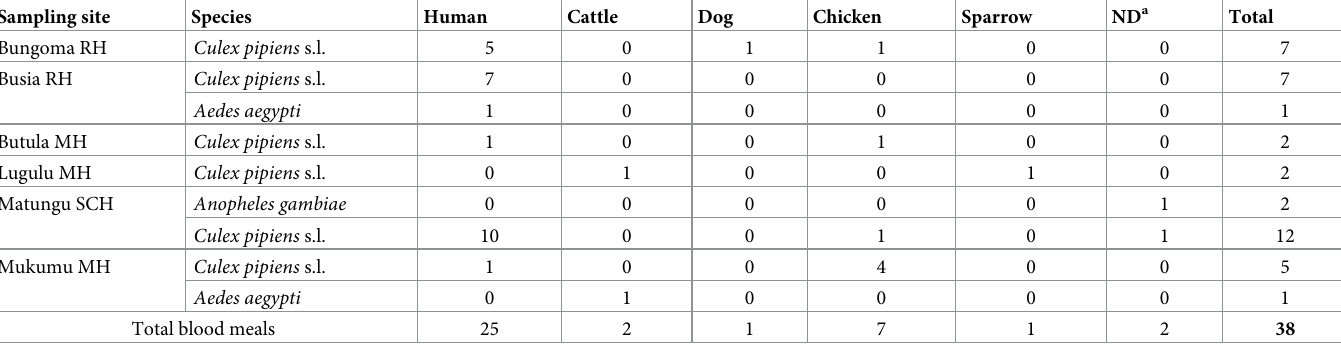
RH = Referral hospital; MH = Missionary hospital; SCH = sub-County hospital. a ND: Not determined by the two